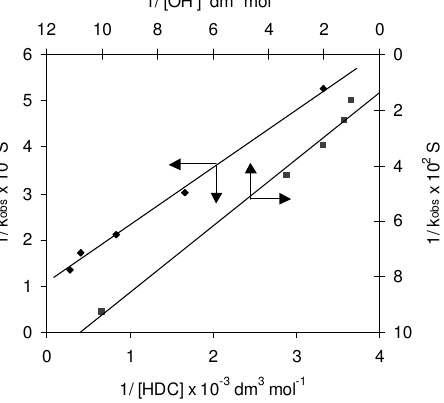
Figure 3. Verification of rate law (eq. 7). Plots of 1/k (conditions as in Table